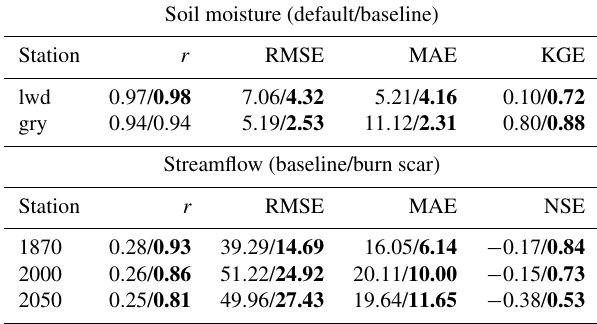
Table 1. Quantitative evaluation metrics for the simulated soil mois- ture and streamflow when compared against observations. The met- rics include the Pearson correlation coefficient ( r ), root mean square error (RMSE), and mean absolute error (MAE). In addition, the comprehensive metrics Kling–Gupta efficiency (KGE) and Nash– Sutcliffe efficiency (NSE) are used to evaluate model-simulated soil moisture and streamflow, respectively. For soil moisture, the num- bers in front of “/” are calculated between the default run (i.e., un- calibrated run) and the observations, whereas the numbers follow- ing “/” are the corresponding values in the baseline simulation (the dashed purple line in Fig. 4). For streamflow, the numbers in front of “/” are computed between the baseline run (dashed purple line in Fig. 6) and the observations, while the numbers behind “/” are for burn scar simulation (red line in Fig. 6). If the model performance regarding a certain metric is enhanced in the burn scar simulation, the number after “/” is